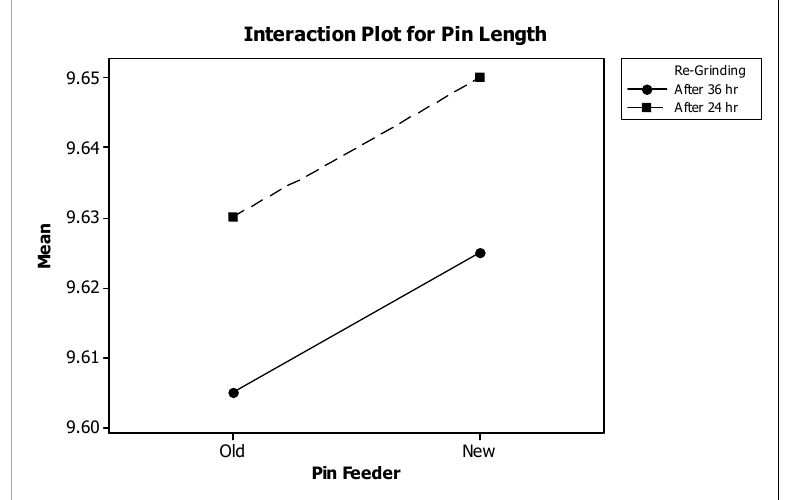
Fig. 7. Interactions Plot for Pin